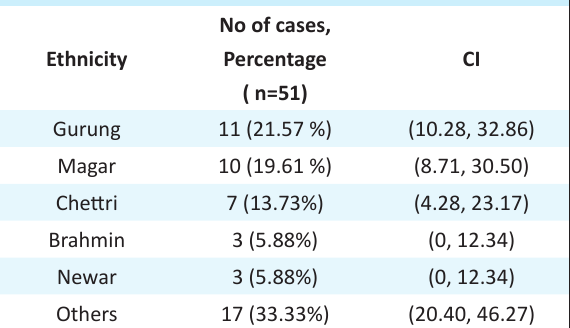
Table 2. Distribution of cases according to Ethnicity.